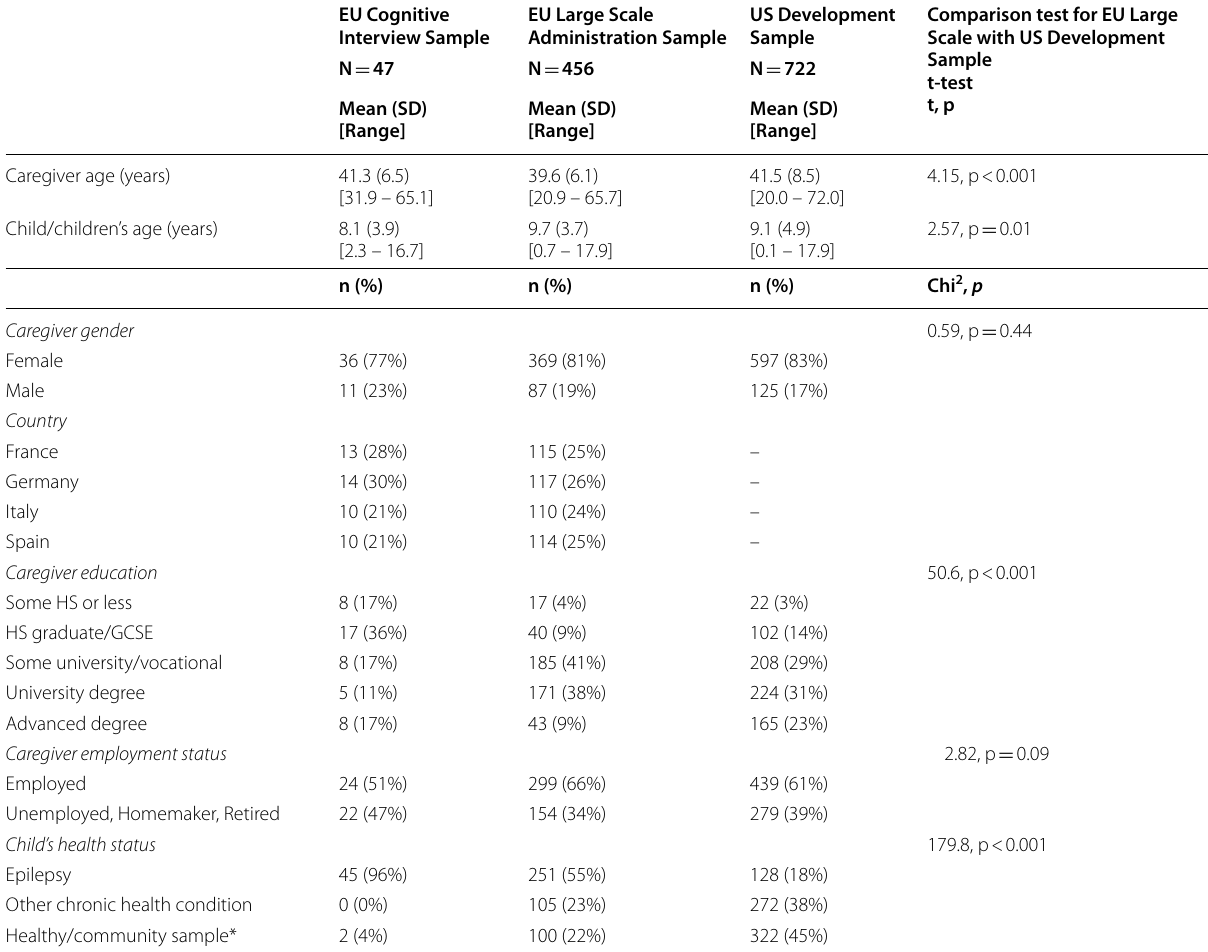
Table 1 Demographics of study samples in the European Union and the United